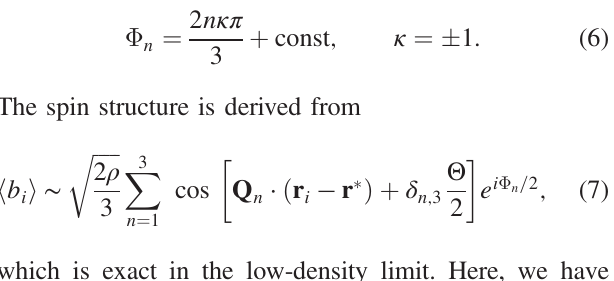
FIG. 6 Phase diagram near the field-induced QCP for a system with the single-boson dispersion of Ba 3 Mn 2 O 8 as a function of V 1 , V 2 , and V 4 . The dashed line indicates a boundary across which the Γ 5 vertex changes sign. The states corresponding to the indices (1) – (11) are summarized in Fig.